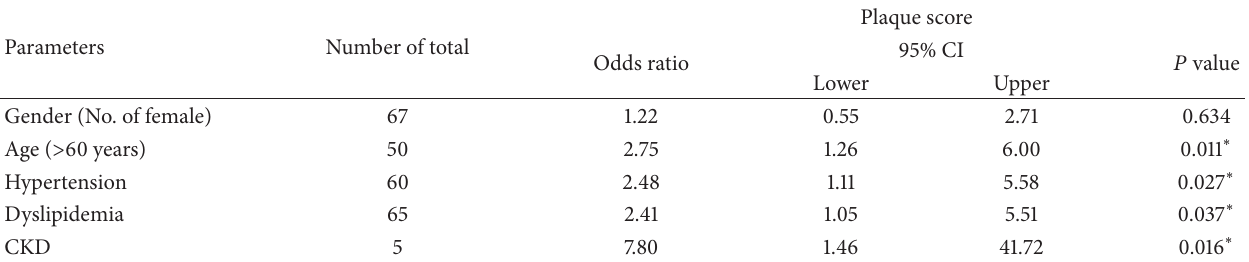
Table 2: The effect of atherosclerosis risk factors on carotid plaque score in subjects with type 2 diabetes ( 𝑛 = 106 ).